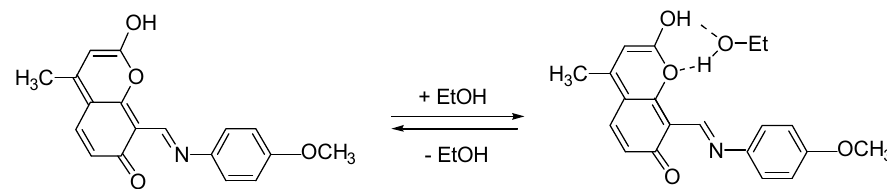
Figure 4. Absorption spectra (1, 6), fluorescence spectra at λ ex = 332 nm (5), 375 nm (2, 7), 461 nm (3) and fluorescence excitation spectra at λ reg = 461 nm (4) before (1–5) and after (6, 7) UV irradiation by the external source of model 3 in ethanol solution. Reproduced from Ref. [16] with permission from the Royal Society of Chemistry.